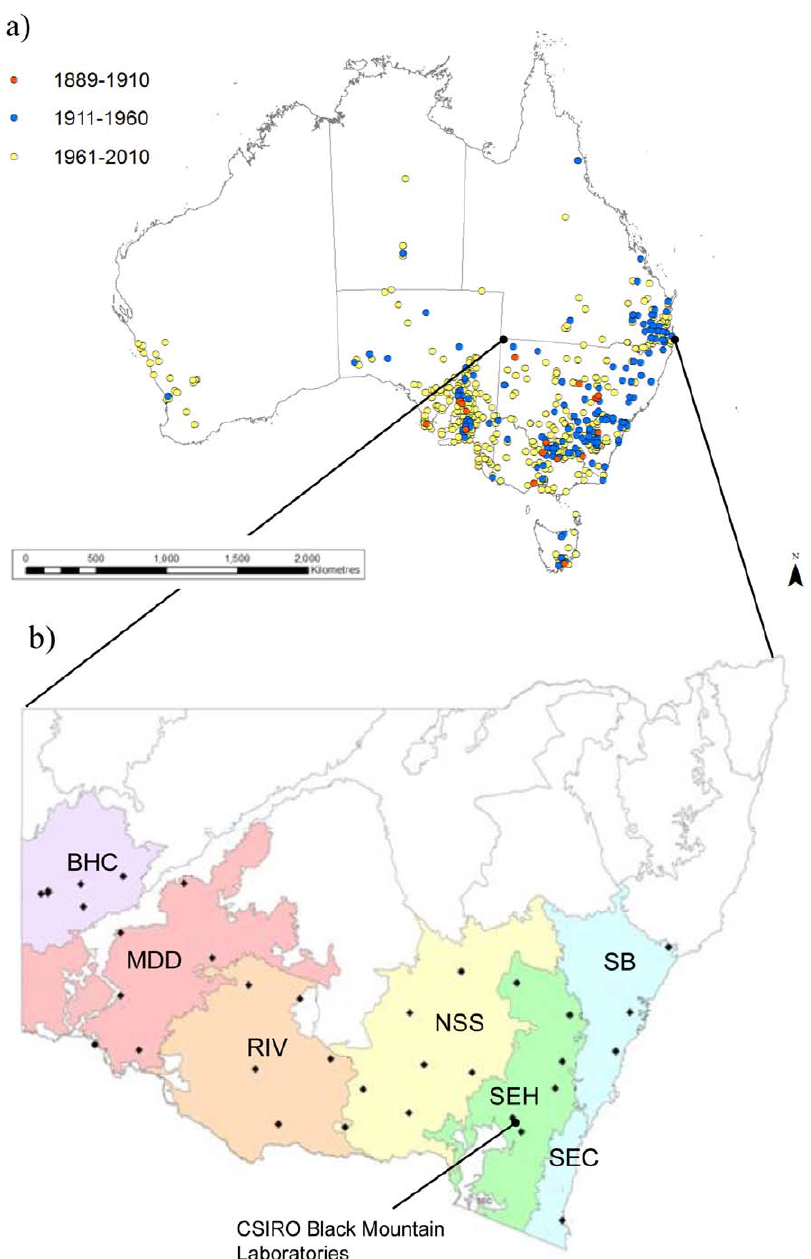
Figure 1. Distribution of Echium plantagineum in Australia and location of collection sites across south-eastern Australia. (a) Herbarium records from the periods 1889–1910, 1911–1960 and 1961–2010 based on data obtained from Australia’s Virtual Herbarium (2009 Council of Heads of Australasian Herbaria Inc) show the pattern of spread since introduction. (b) Distribution of study sites (depicted by black diamonds) across south-eastern Australia, grouped by IBRA bioregion (coloured). BHC=Broken Hill Complex, MDD=Murray Darling Depression, RIV=Riverina, NSS=NSW (New South Wales) South-Western Slopes, SEH=South-Eastern Highlands, SB=Sydney Basin, SEC=South-East Corner. Note that for all analyses SB and SEC were combined into a single coastal bioregion (COAST). The location of CSIRO Black Mountain Laboratories (S 35.27 u , E 149.12 u ) where the glasshouse experiment was conducted is indicated.